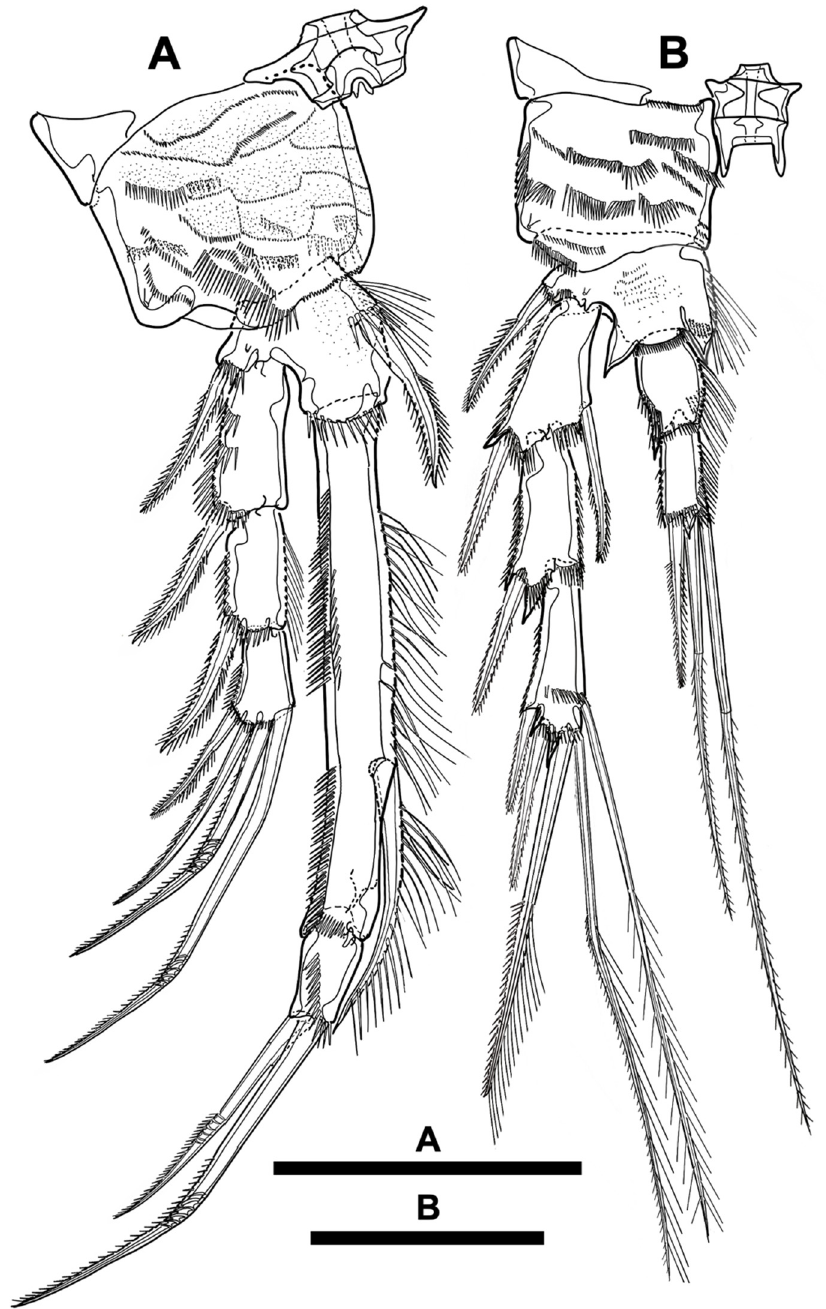
Figure 29. Line drawings of Phyllopodopsyllus similis sp. nov. female (holotype): ( A ) P1; ( B ) P2. Scale bars: 50 µm.